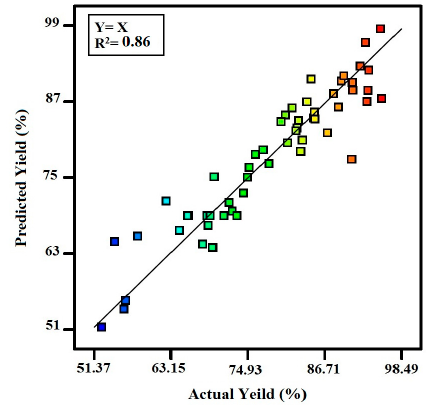
Figure 5. Predicted yield versus Experimental yield using regression